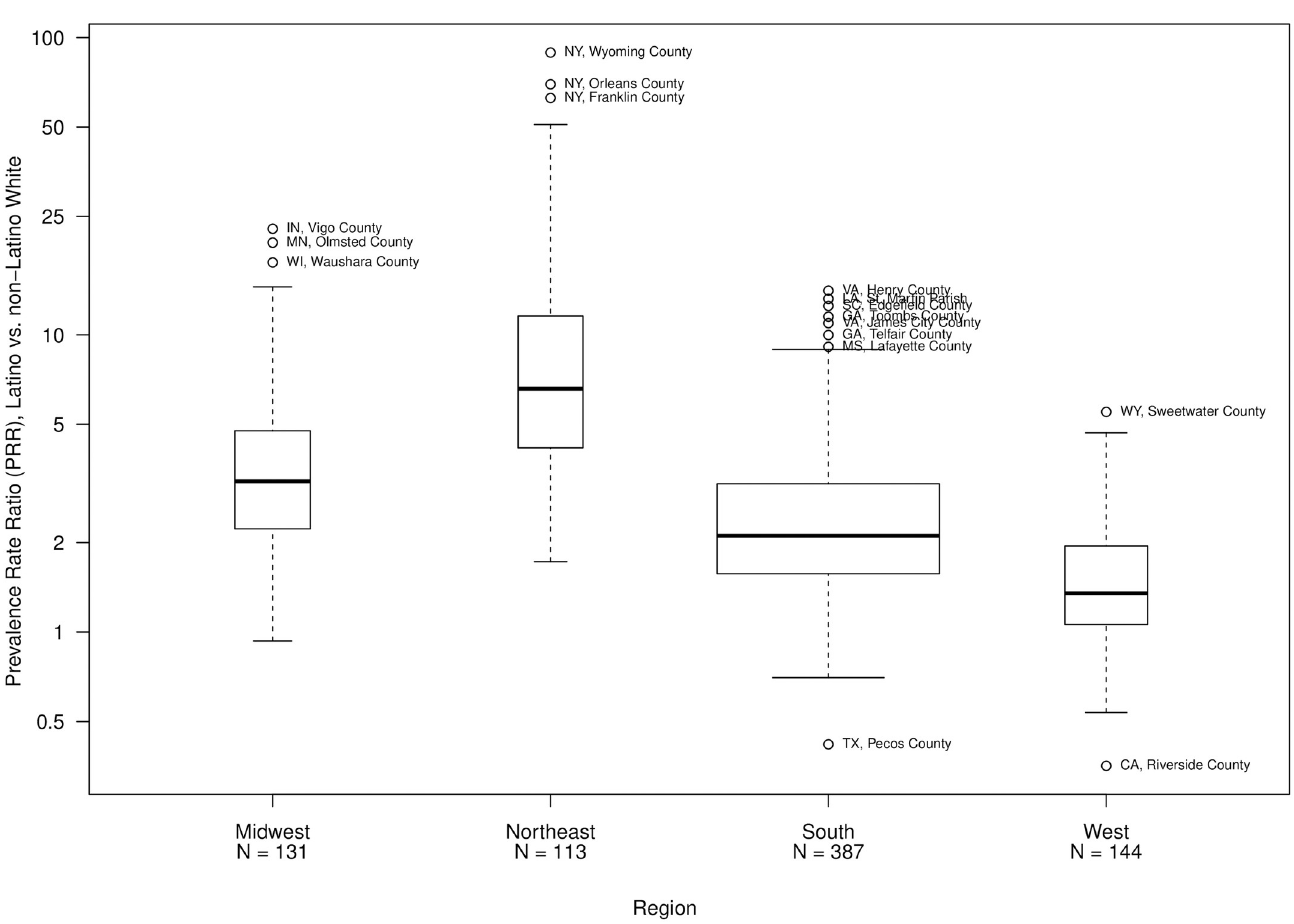
Fig 2. Distribution of Latino and Non − Latino white diagnosed HIV prevalence rate ratio, by region (N = 775